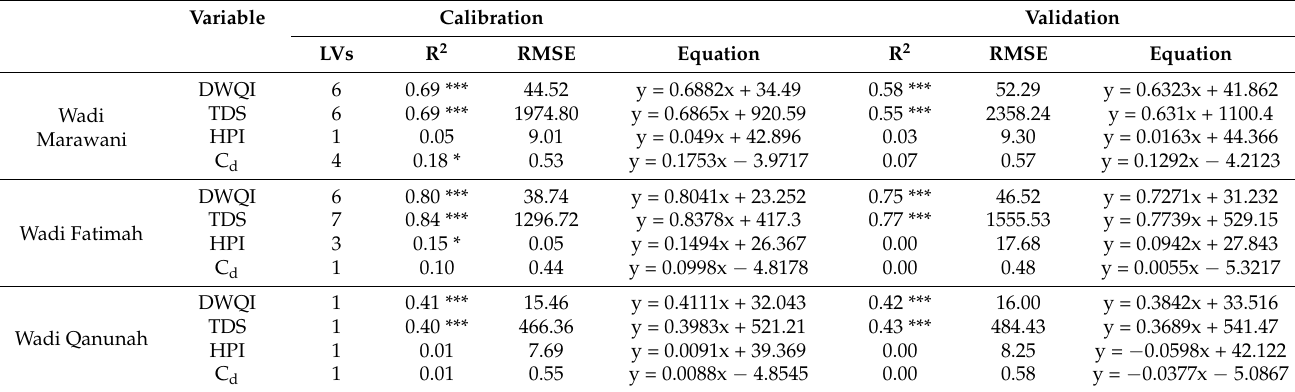
Table 9. Outcomes of calibration and validation models of PLSR for the association between observed and predicted values for DWQI, TDS, HPI, and C d of the three wadies.